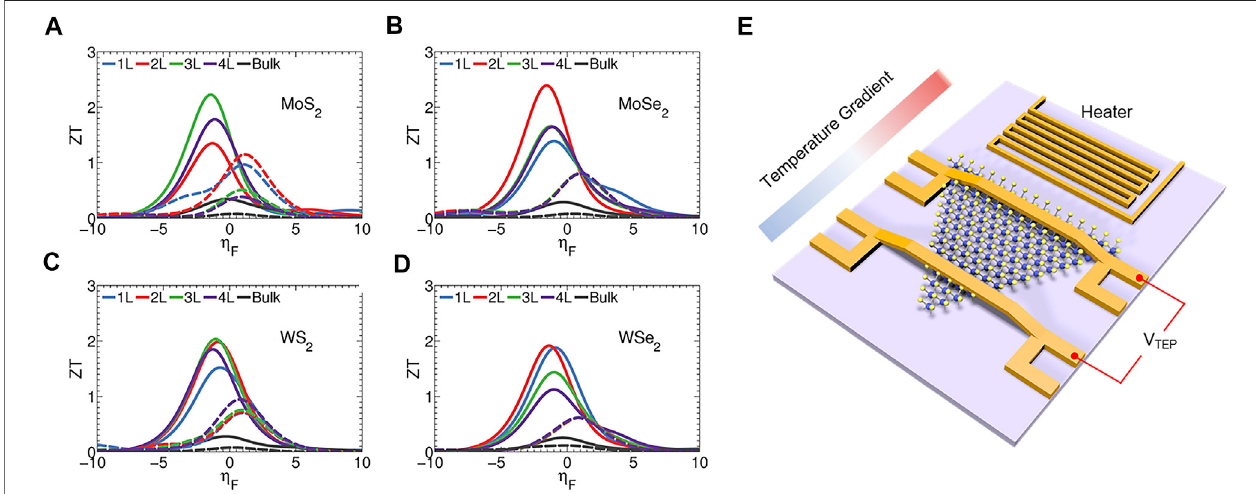
FIGURE5 | ZT at 300 K for (A) MoS 2 , (B) MoSe 2 , (C) WS 2 , and (D) WSe 2 with bulk (black), 1 L (blue),2 L (red), 3 L (green), and 4 L(purple) structures. The n -type ZT isplottedwithasolidlineand p -type ZT isplottedwithadashedline,asafunctionofthereducedFermienergy, η F .ReprintedwithpermissionfromRef.[42],Copyright 2014, American Institute of Physics. (E) The typical structure of the thermoelectric micro-device